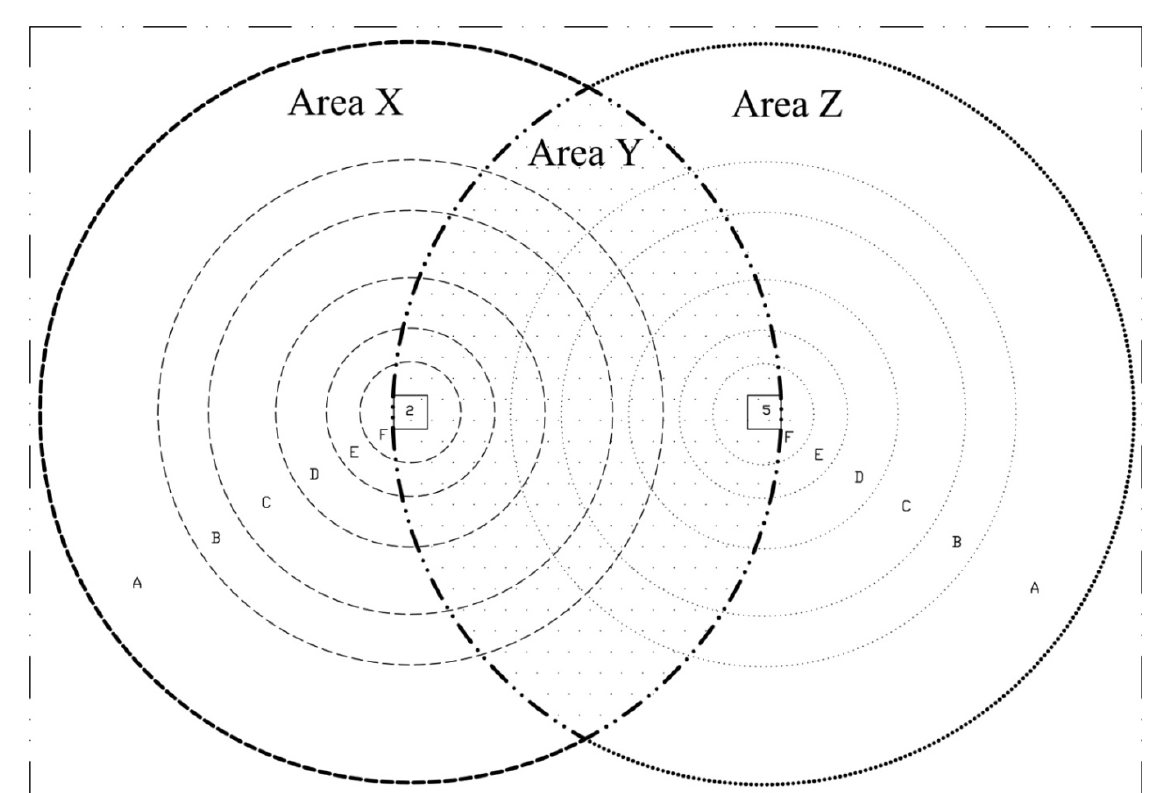
Figure 18. Selected area of concrete